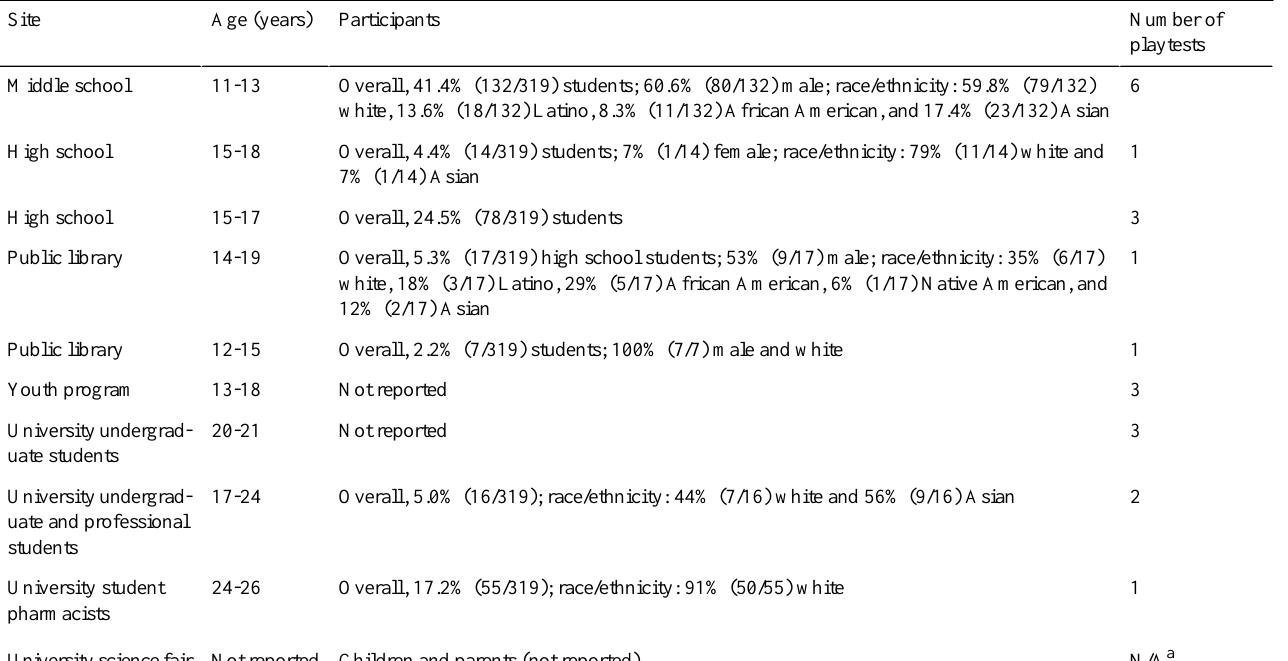
Table 1. Playtest sites and characteristics